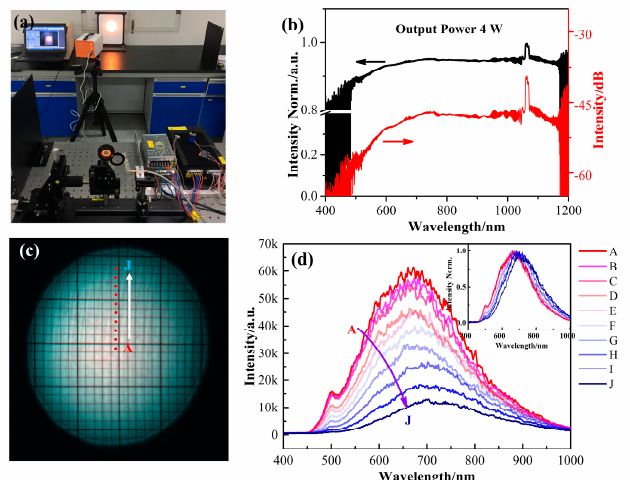
Figure 1. Experimental setup and characterization: ( a ) Photo of the active HSI system in laboratory. ( b ) Output spectrum of the SC laser at the range of 400–200 nm. ( c ) False-color image of the SC laser spot by the hyperspectral imager. ( d ) Spectral profiles of the 13 points (A–J) marked in ( c ) recorded by the hyperspectral imager.